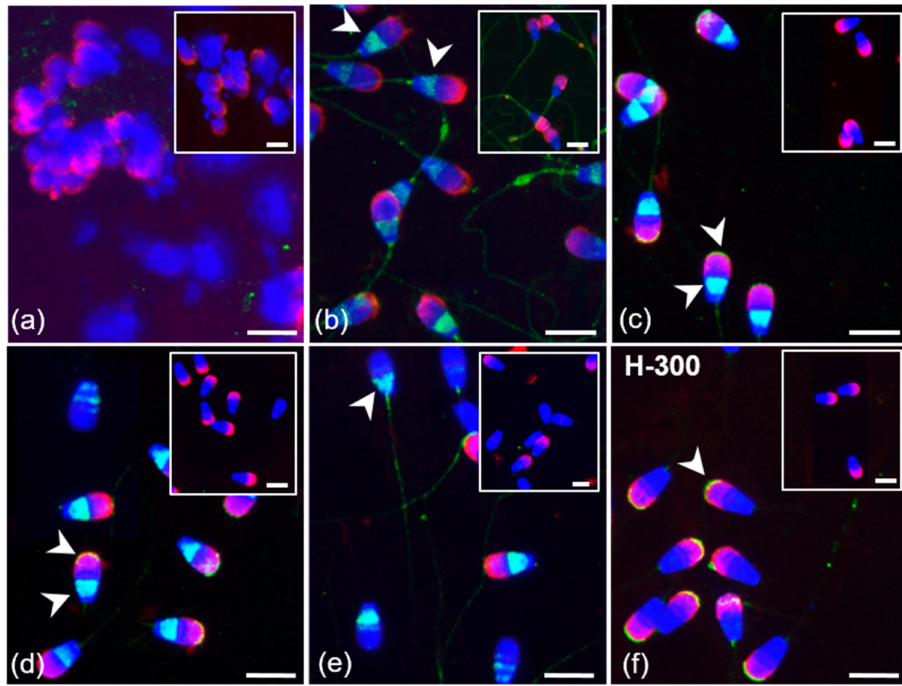
Figure 7. Localization of GPER1 in bull spermatozoa. Spermatozoa from testes ( a ) and the cauda epididymis ( b ); freshly ejaculated sperm ( c , f ); spermatozoa after in vitro capacitation ( d ); sperm after acrosome reaction ( e ). Spermatozoa were treated with polyclonal antibody K-19 (green) ( a – e ) or with polyclonal antibody H-300 ( f ) or rabbit IgG isotype control ( a – f ). Nuclear DNA was stained by DAPI (blue), and sperm acrosomes were labeled by PNA lectin (red). Isotype controls are shown in the top right corner of the figures. Arrows show a positive reaction in the equatorial and post-acrosomal region or apical acrosomal part of sperm head. Scale bar represents 10 µ